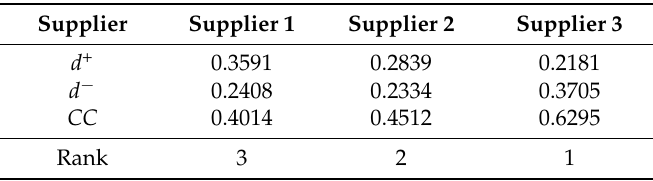
Table 8. The ranking of the supplier.